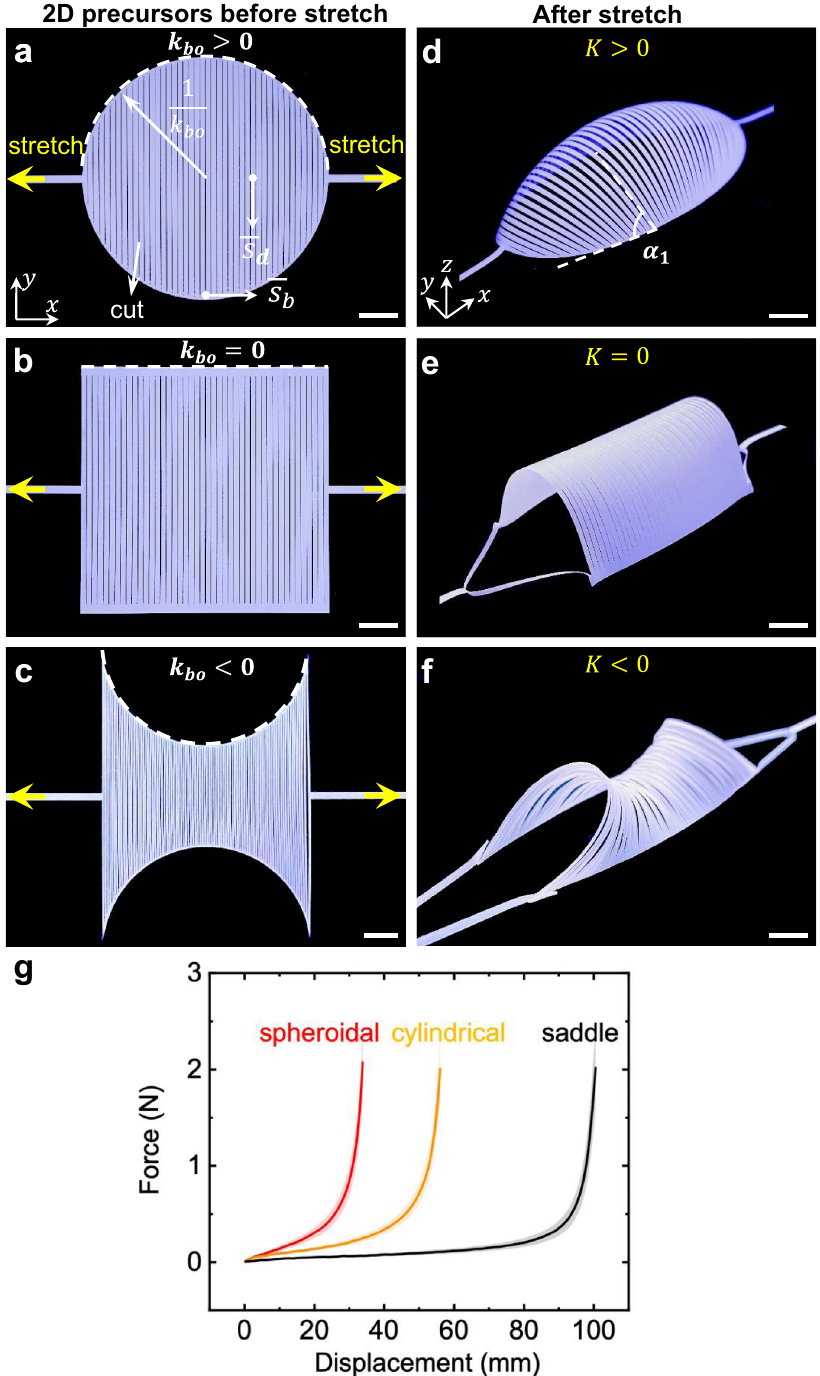
Fig. 1 Shape shifting of 3D curved morphologies from 2D kirigami sheets with different cut boundary curvatures subject to uniaxial tension. a – c 2D precursors of three kirigami sheets patterned with parallel cuts but different boundary curvatures k b highlighted in dashed white curves. circular ( a ), square ( b ), biconcave ( c ) samples with positive, zero, and negative boundary curvature, respectively. d – f The corresponding formed 3D curved shapes with different Gaussian curvature K . d Spheroidal shape with K > 0 at an applied strain of 0.30. e Cylindrical shape with K = 0 at an applied strain of 0.65. f Saddle shape with K < 0 at an applied strain of 1.47. Scale bars = 10 mm. g Force – displacement curves for the three 2D precursors. The shaded areas are the standard deviation between four different